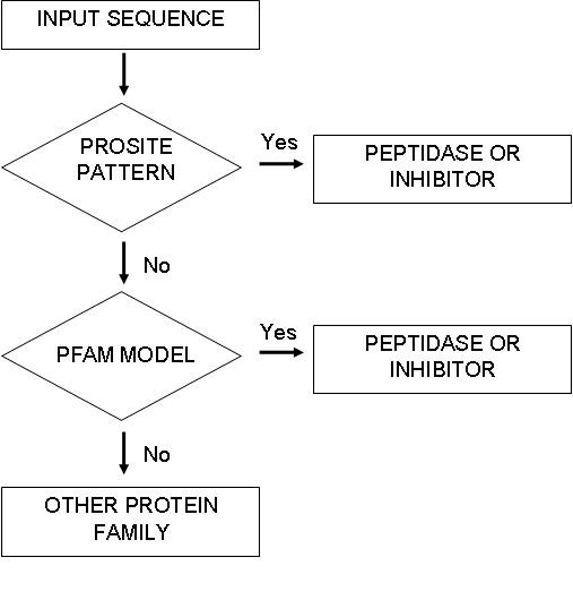
Flow-chart of the decision-tree method for the detection of peptidases and inhibitors.